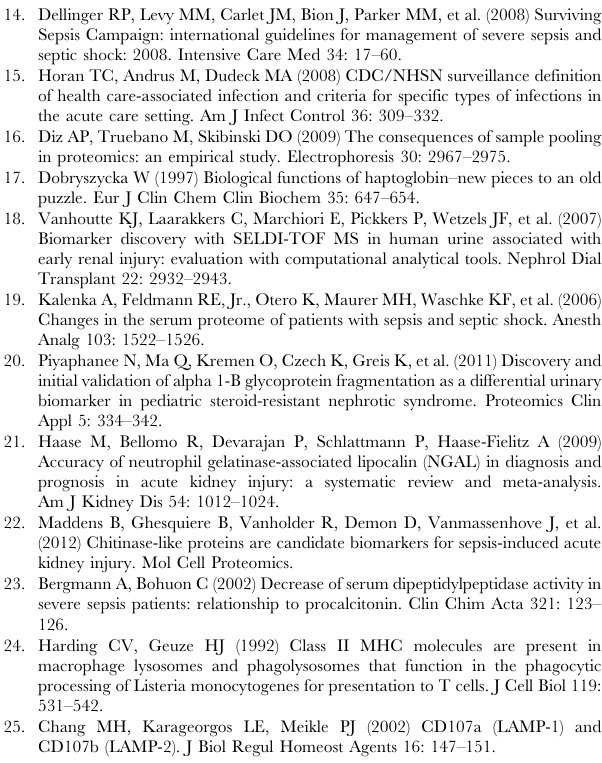
Table S1 Sample size estimation for the verification stage used two-sample t test power calculation by R